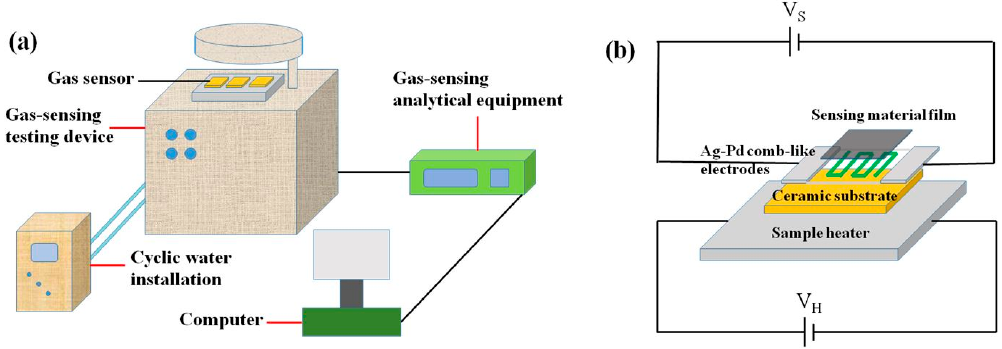
Figure 11. ( a ) The schematic diagram of the CGS-4TPS gas-sensing test system and ( b ) the gas sensor structure.